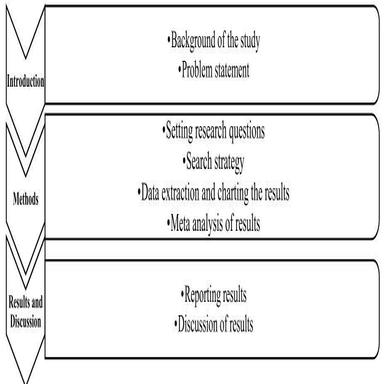
A schematic diagram summarizing the scoping review process.